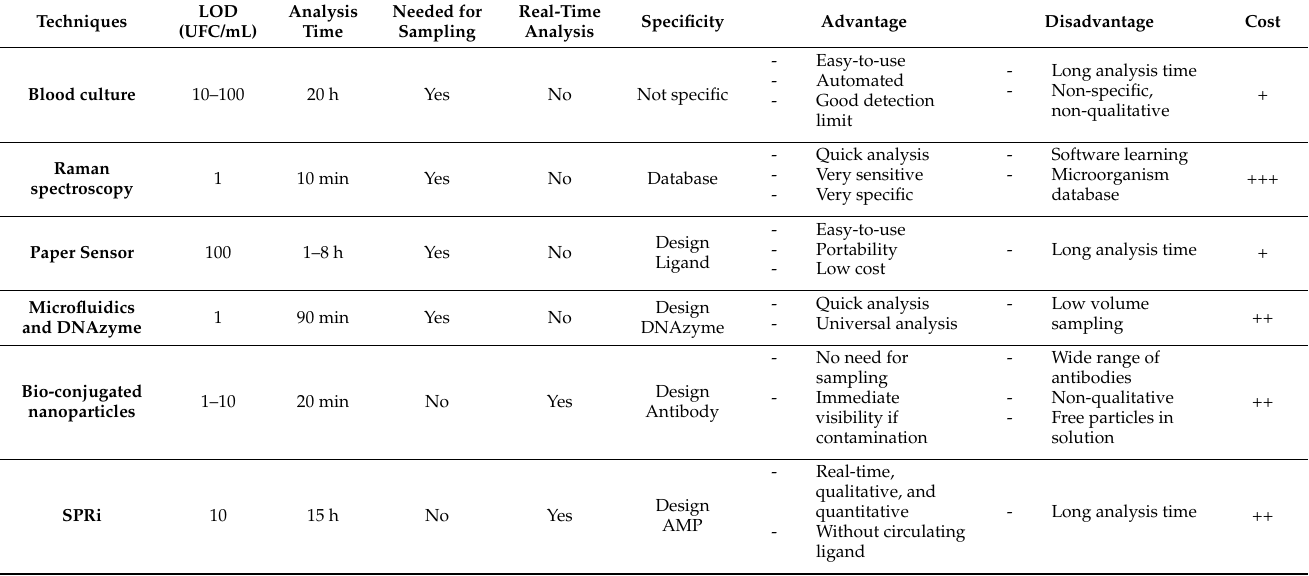
Table 3. Synthesis of different analysis techniques (AMP: antimicrobial peptide; SPRi: